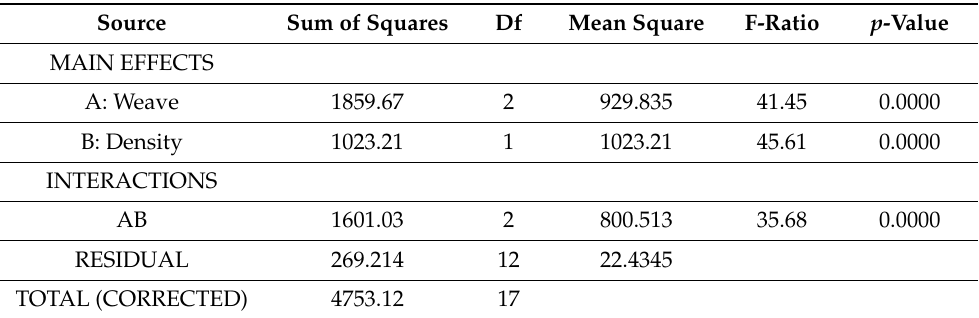
Table 6. Impact of weave and density on the adhesion force for simple fabrics for z1.